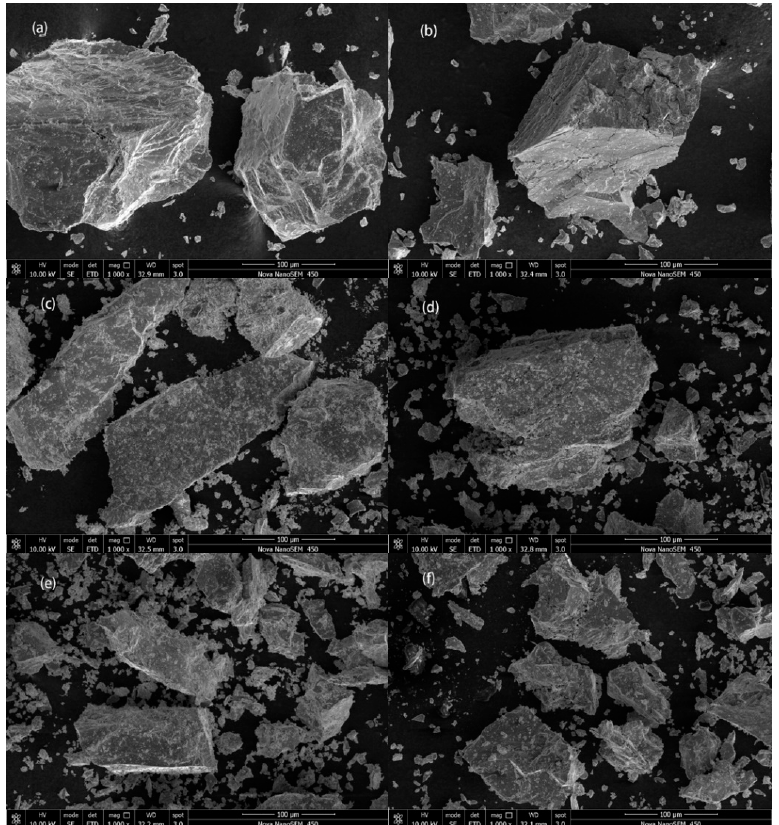
Figure 2. SEM micrographs of ( a , b ) TiFe 0.86 Mn 0.07 Co 0.07 + 4% Mm alloys; ( c , d ) TiFe 0.86 Mn 0.07 Co 0.07 + 6% Mm alloys; and ( e , f ) TiFe + 8% Mm alloys. ( a , c , e ) As-cast; 0.86 Mn 0.07 Co 0.07 ( b , d , f ) After pressure-composition (P–C) isotherms